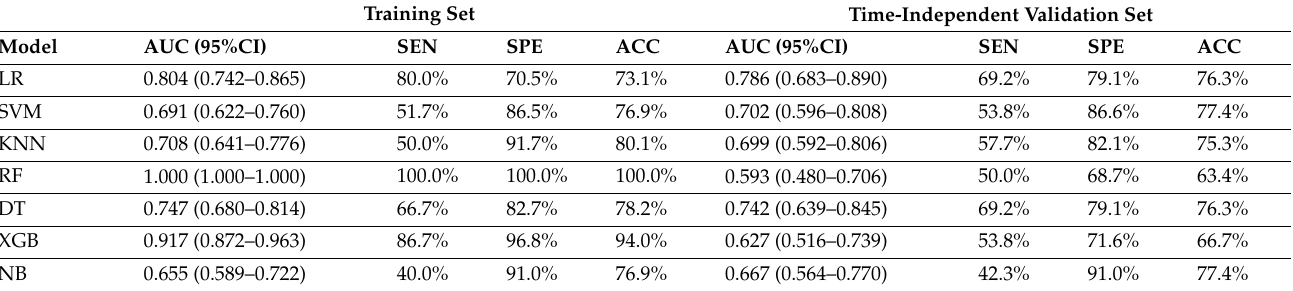
Table 4. Diagnostic performance of seven machine learning classifiers in training and validation sets.